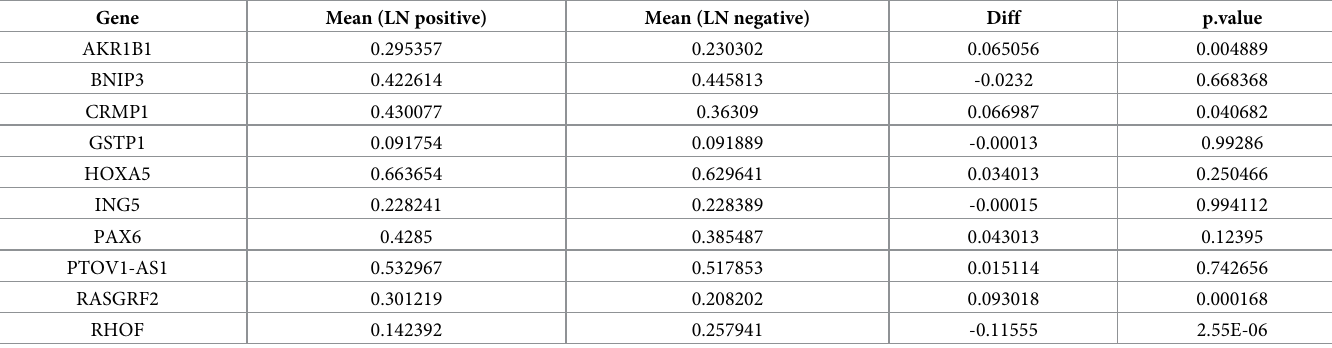
p.value < 0.05 indicates significantly differences between the two